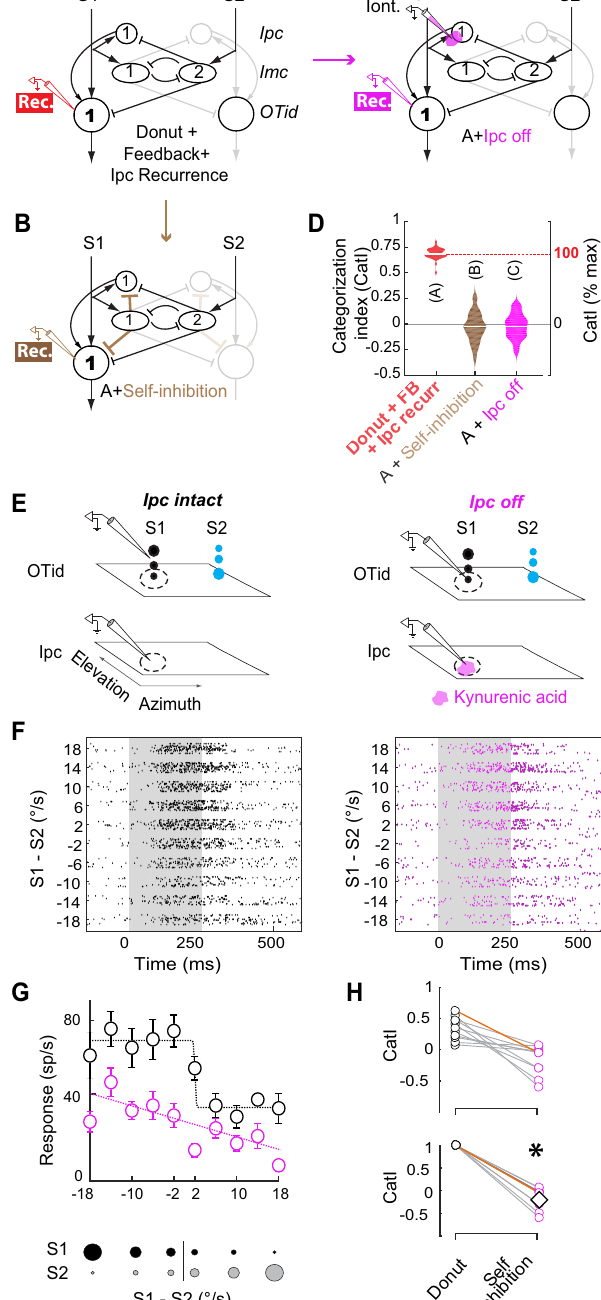
NATURE COMMUNICATIONS| (2022) 13:1680